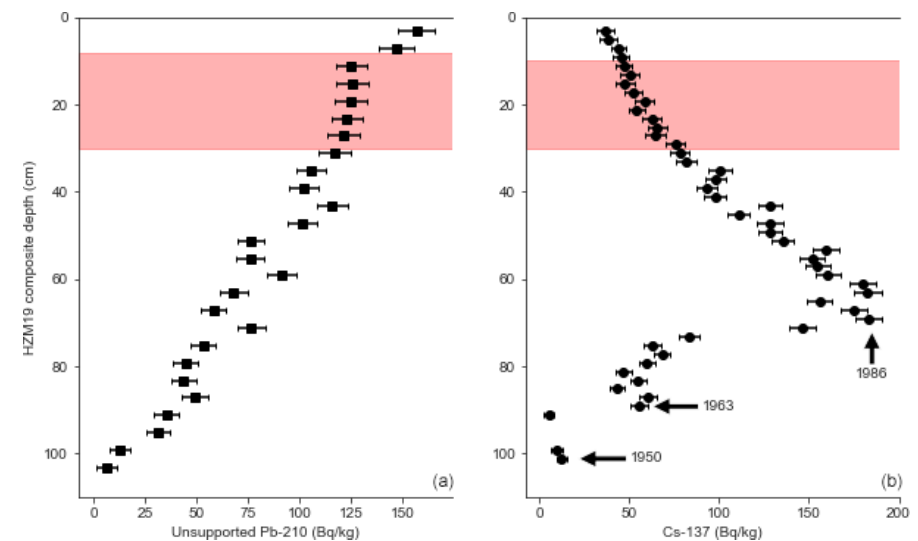
Figure 4. Results of unsupported Pb-210 (a) and Cs-137 (b) measurements with error bars for the uppermost 110cm of HZM19. Shaded areas indicate the plateau shown by Pb-210 data, and black arrows mark peaks assigned to radiochronological events (given numbers are ages in years